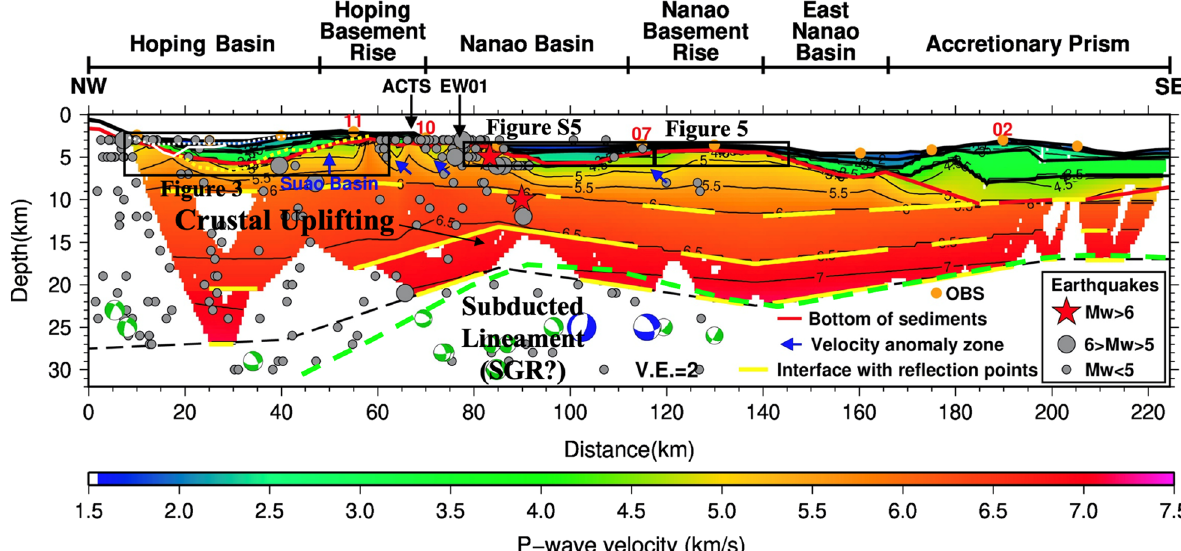
Fig. 10 The P‑wave velocity‑interface model covered by the refracted and reflected rays along MGL0906‑22. The relocated earthquakes (Font et al. 2004) are superimposed on the model. The focal mechanisms of the earthquakes (BATS) are shown by the blue (Mw ≥ 6 ) and green (6 > Mw ≥ 5) beach balls, respectively. The black arrows show the location for the intersection of EW9509‑01 (EW01) and MGL0906‑12 (ACTS). The black dashed line shows the Moho. The black frames show the areas of Figs. 3, 5 and Additional file 1: Fig. S5. The yellow dashed line, white line and white dashed line show the unconformities of the LMCS section in Fig. 3b. The Moho from van Avendonk et al. (2016) is identified by the green line. SGR: Subducted Gagua